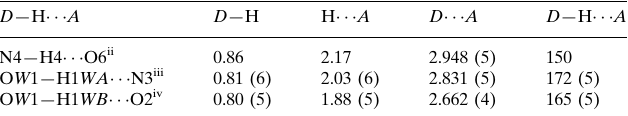
Hydrogen-bond geometry (A˚ , (cid:3)